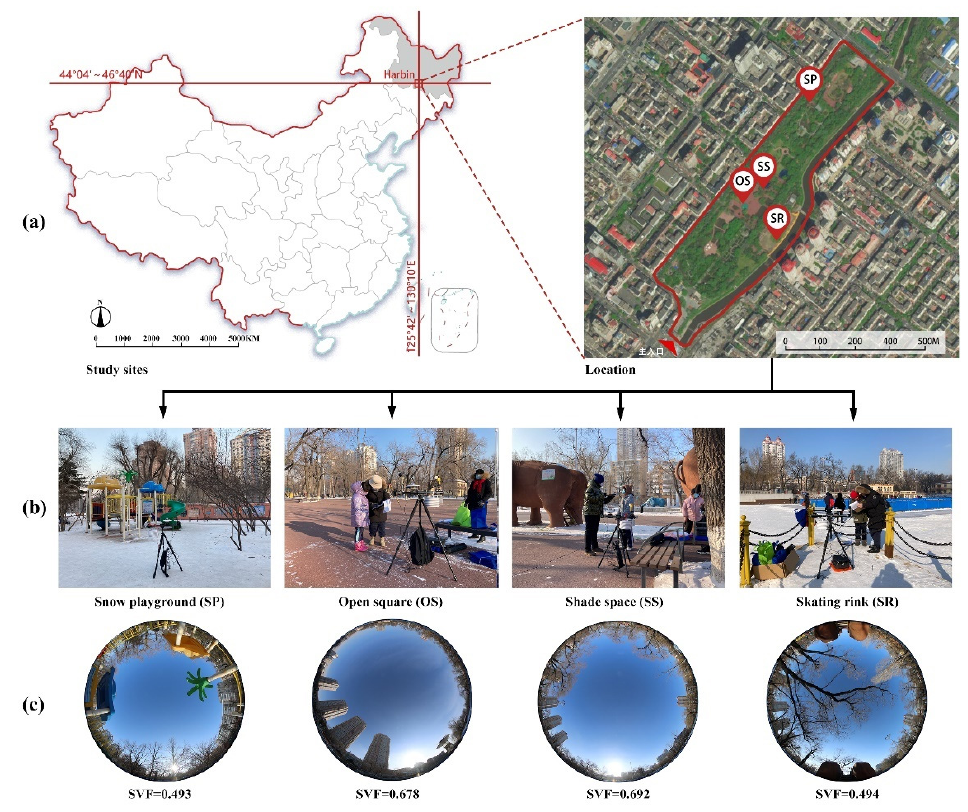
Figure 2. Site location and measurement spaces: ( a ) site location, ( b ) photographs of open spaces, and ( c ) fisheye photographs of open spaces (( b , c ) were taken by the author on 18 January 2022).